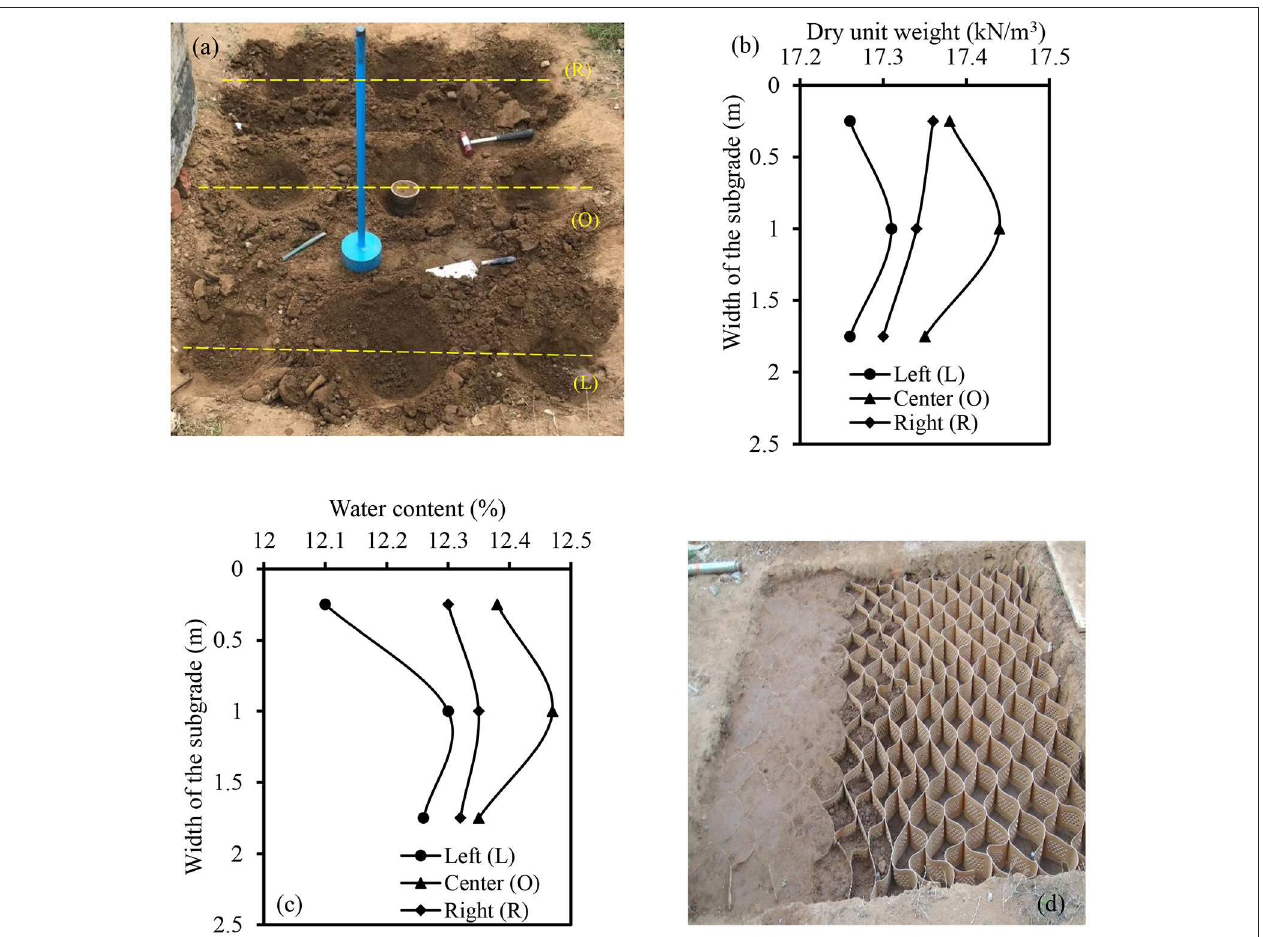
FIGURE 3 | Preparation of different subgrade sections: (a) collection of soil samples; (b) dry unit weight distribution; (c) OMC variation; and (d) partially filled geocell